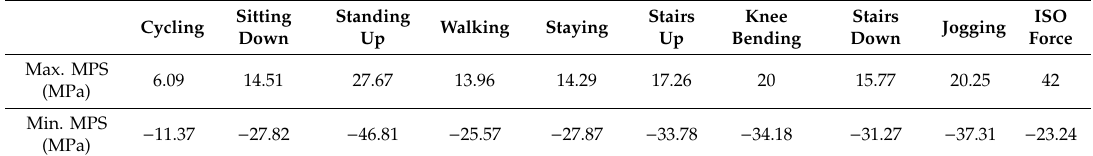
Table 5. Maximum and minimum principal stresses for di ff erent loading conditions.